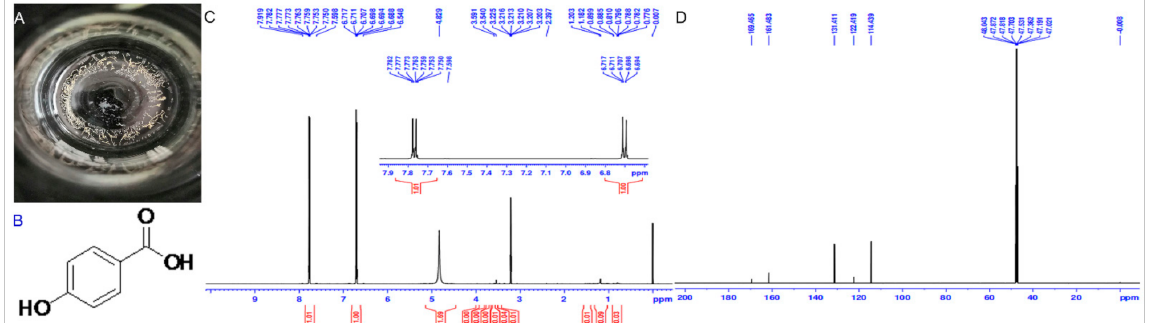
Figure 2. Morphology and structure identification of HBA. Note: ( A ) physical state; ( B ) structural formula; ( C ) 1 H-NMR diagram of HBA (500 MHz, MeOD); ( D ) 13 C-NMR of HBA (126 MHz, MeOD).